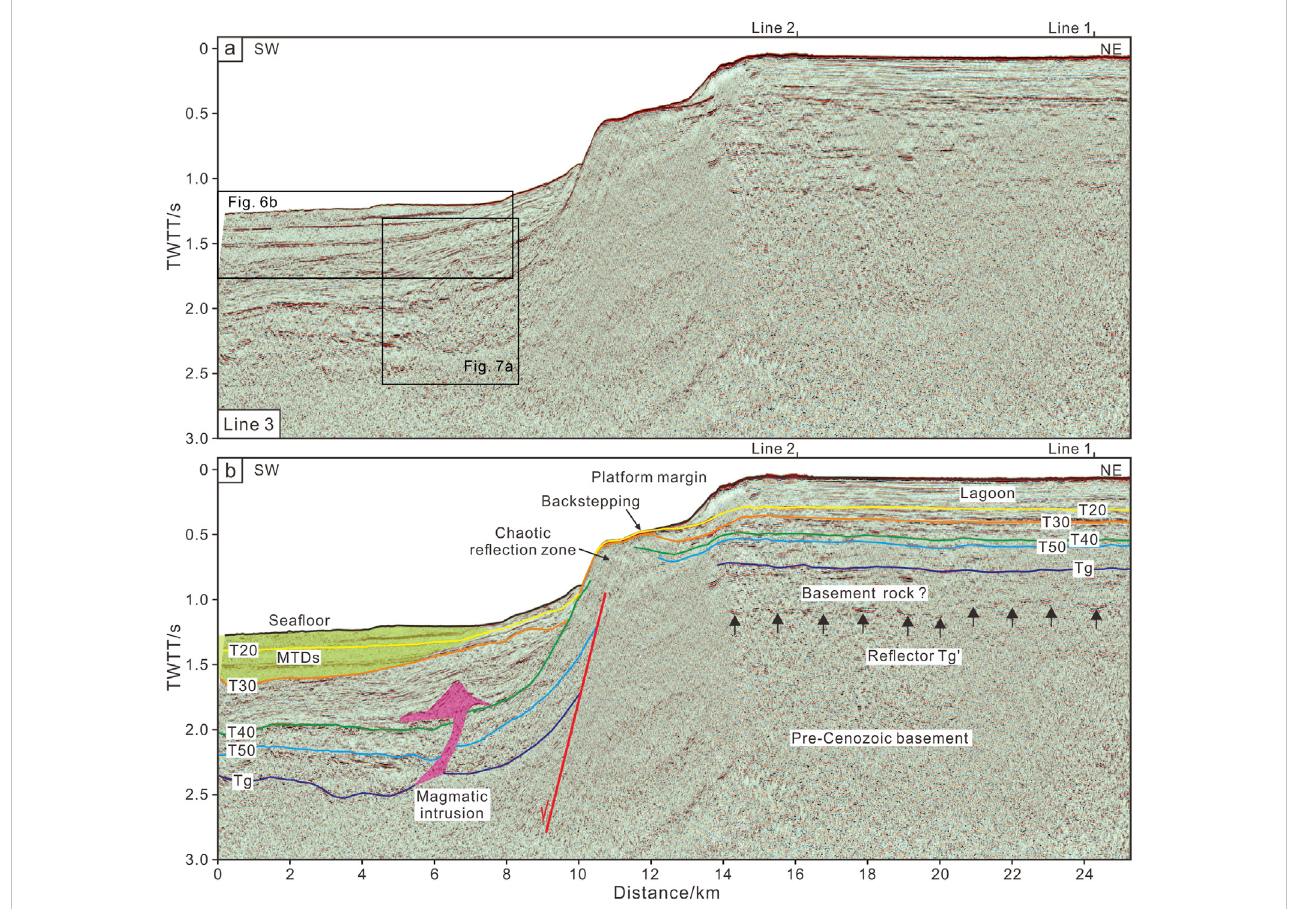
FIGURE 5 Line 3 multi-channel seismic re fl ection pro fi le (A) and its interpretation (B) . See Figure 1 for location. Red line represents normal fault. Carmine area representsthecon fi gurationofamagmatic intrusion.Translucentgrass greenareamarkstheMTDs.Blackarrowsmarkthelocationofre fl ector Tg ’ .T20,T30, T40, T50, Tg, Tg ’ : seismic re fl ectors. TWTT: two-way travel